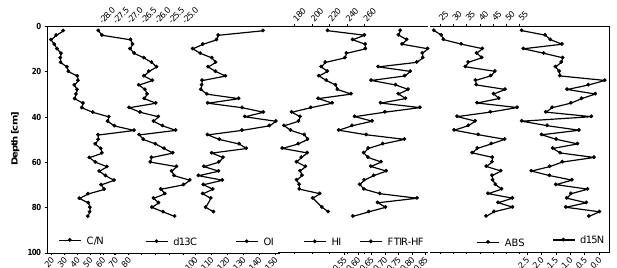
1 Figure 2: Records of decomposition proxies: C/N ratios, δ 13 C (‰), oxygen and hydrogen 2 Figure 2. Records of decomposition proxies: C/N ra- indices (OI, HI (mg CO 2 g -1 TOC)) determined by Rock Eval ® analyses, FTIR decomposition 3 tios, δ 13 C(‰), oxygen and hydrogen indices (OI, HI index 1630/1053 cm -1 , UV-ABS of NaOH peat extracts and δ 15 N (‰) in bulk peat of the KK 4 (mgCO 2 g − 1 TOC)) determined by Rock Eval ® analyses, FTIR core. 5 decomposition index 1630/1053 cm − 1 , UV-ABS of NaOH peat extracts and δ 15 N(‰) in bulk peat of the KK